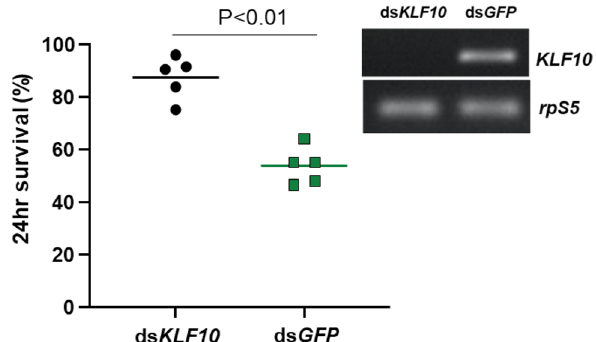
Figure 2. KLF10 affects the survival of bacterial infection. dsKLF10 increased the survival upon Serratia challenge. The KLF10 knockdown was verified by RT-PCR.